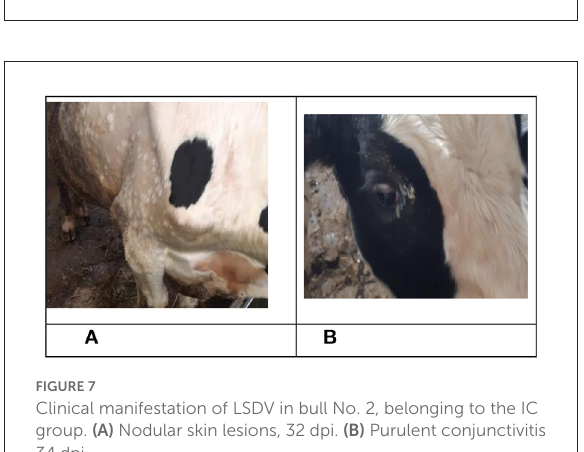
FIGURE7 Clinical manifestation of LSDV in bull No. 2, belonging to the IC group. (A) Nodular skin lesions, 32 dpi. (B) Purulent conjunctivitis 34